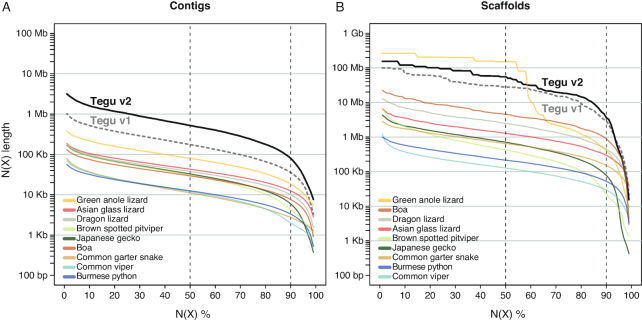
Comparison of assembly contiguity. N(x)% graphs show the contig (A) and scaffold (B) sizes (y-axis), where x% of the genome assembly consists of contigs and scaffolds of at least that size. The tegu lizard v1 and v2 assemblies are shown in gray and black. All other assemblies are sorted by the N50 values in the insets. Dashed lines mark the N50 and N90 values.